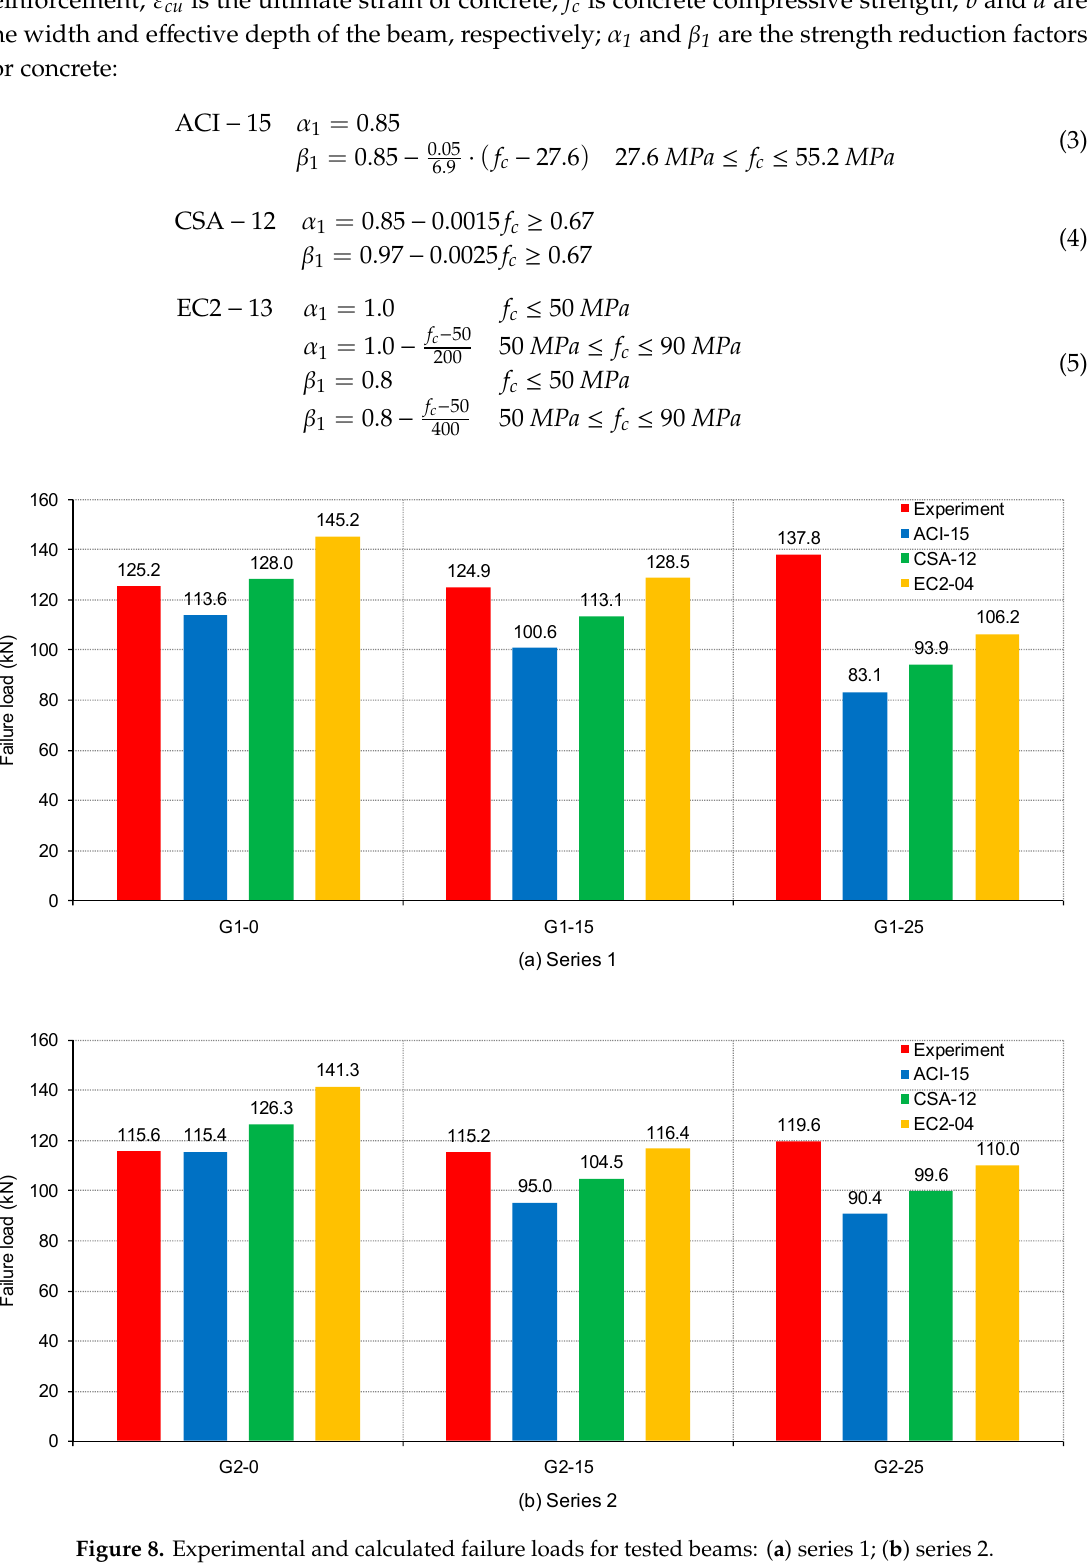
Figure 8. Experimental and calculated failure loads for tested beams: ( a ) series 1; ( b ) series 2.